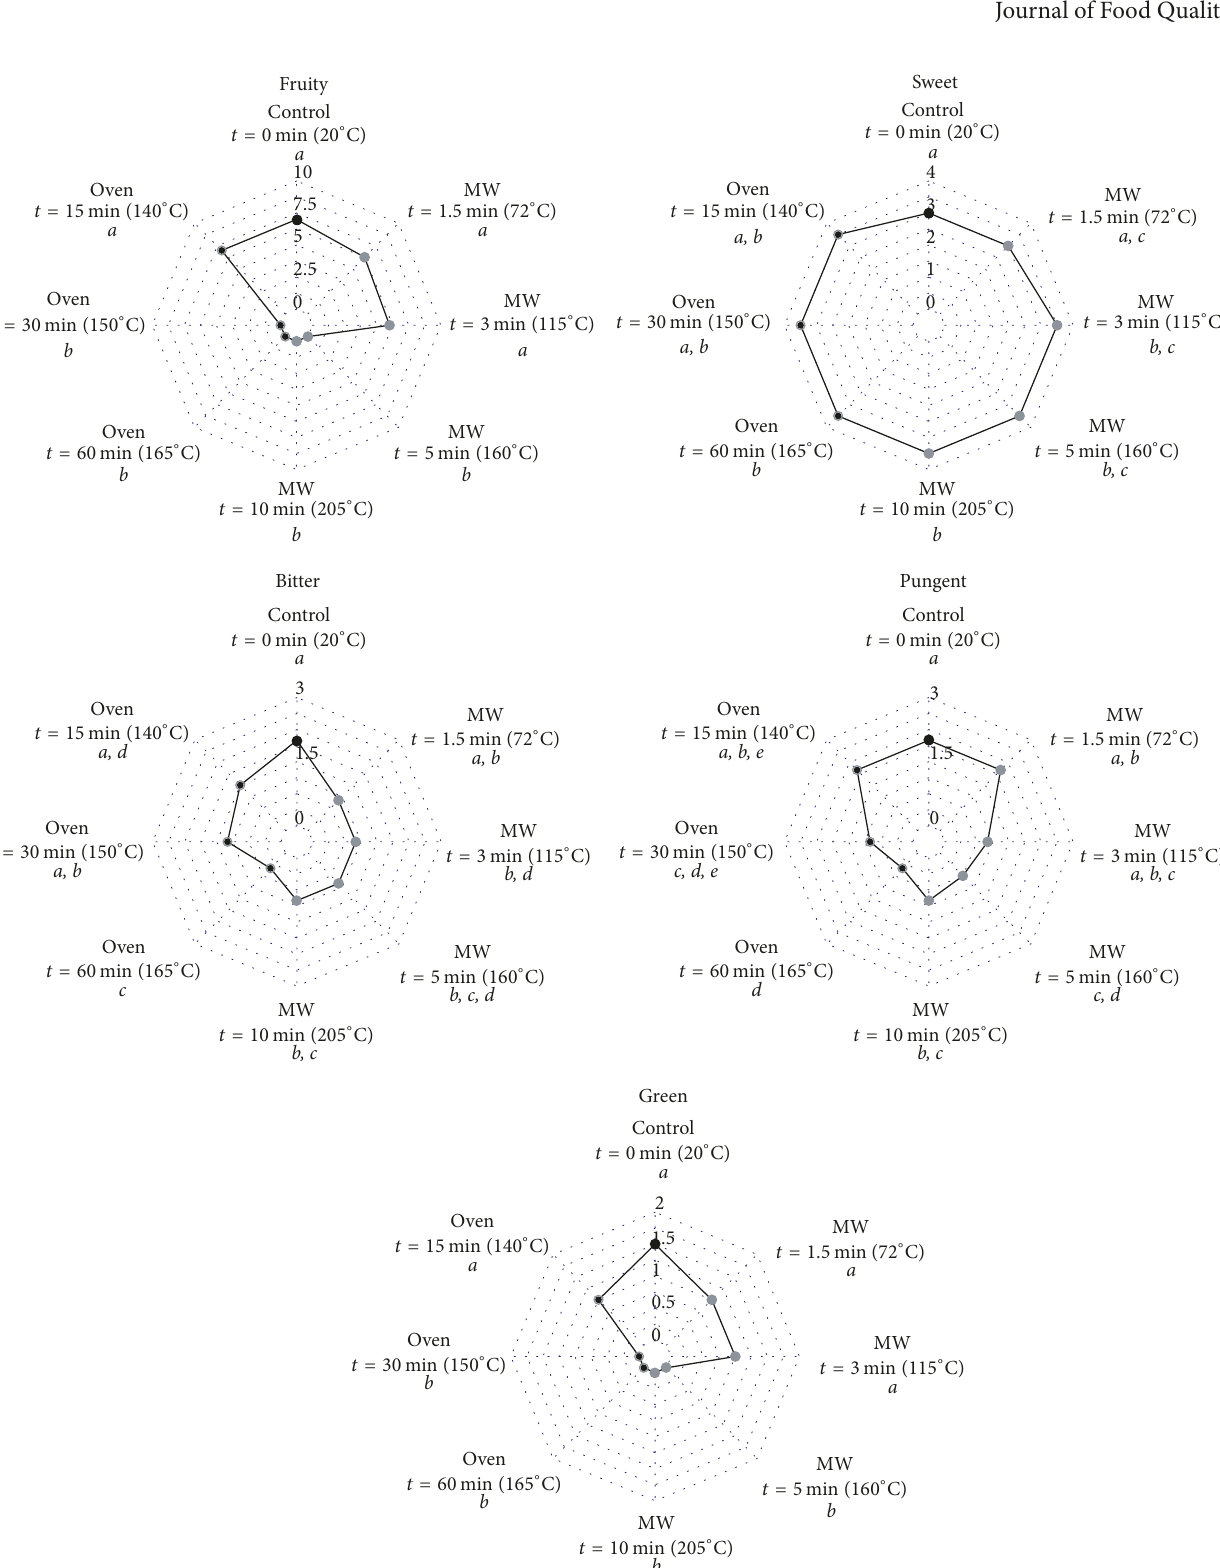
Figure 3: Radar plot of the median intensities of gustatory-retronasal olive oil positive attributes (fruity, sweet, bitter, pungent, and green) perceived by a sensory panel before (control, t0 min – black circles) and after different cooking processes: oven (grey-black circles) and microwave (MW, grey circles) heating during different time periods (oven at 2000 W: 15 to 60min, 140 to 165 ∘ C; and microwave at 1200 W: 1.5 to 10 min, 72 to 205 ∘ C). Significant statistical differences were evaluated using the Kruskal-Wallis nonparametric test followed by the Dunn’s test, if a difference was found, considering the intensity scales of the IOC guidelines [35, 36]. For each descriptor figure, median intensities with different small letters are different from a statistical point of view ( 𝑃 value ≤ 0.0344 for Dunn’s